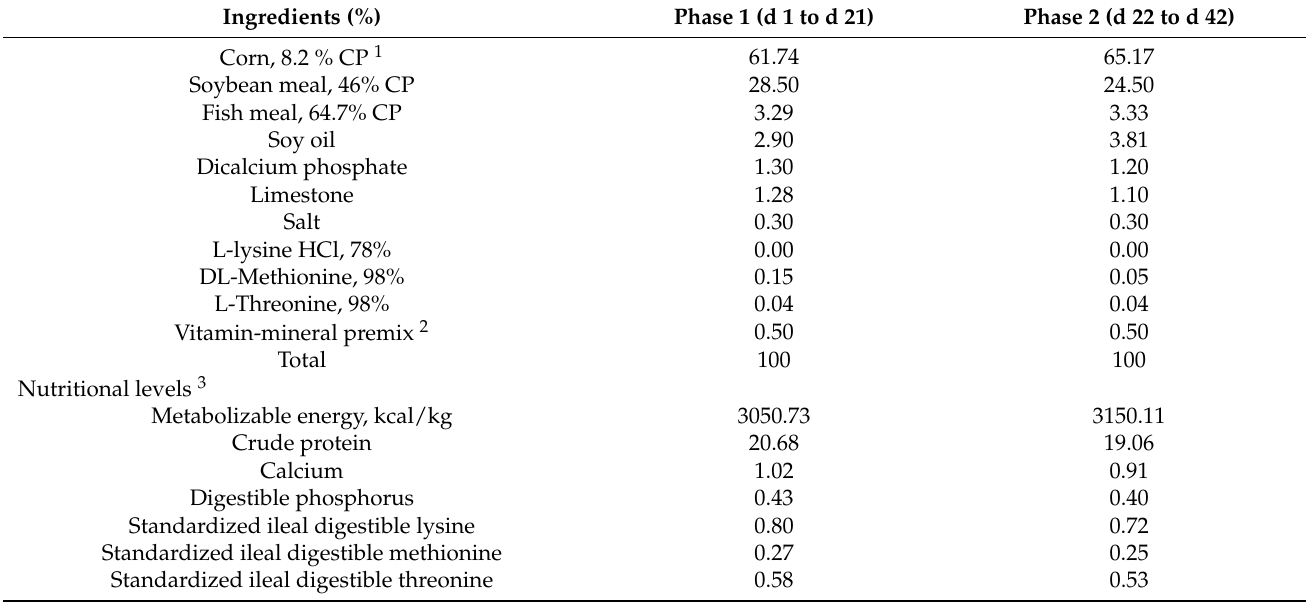
Table 1. Composition and nutrient levels of basal diets (DM 1